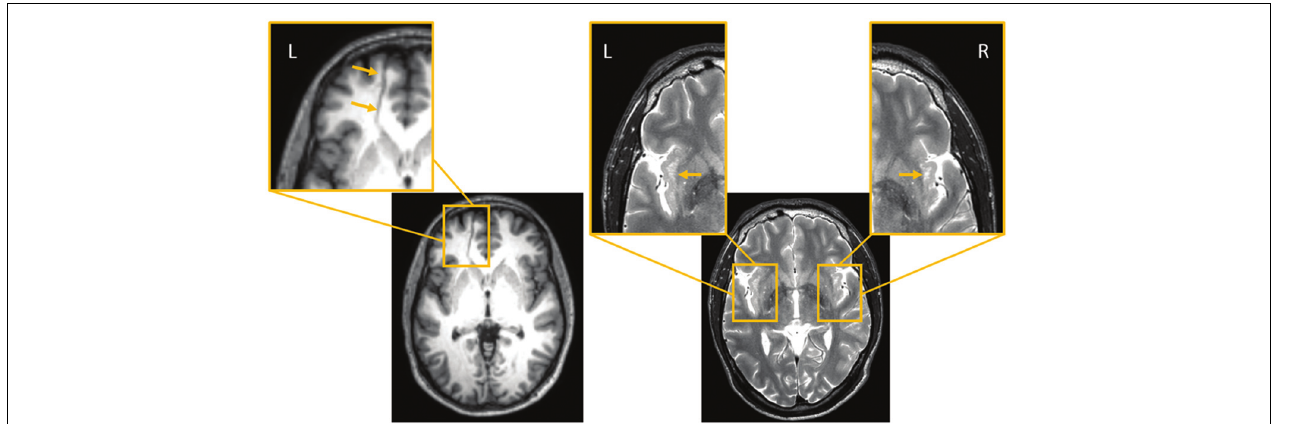
FIGURE 2 | (Left) : Subject 1. (1) Axial FLAIR MRI image shows a transmedullary vein close to the head of the left caudate nucleus crossing the medial frontal lobe substance and reaching the superior longitudinal sinus. This region has been expanded to depict the venous angioma (orange arrows; left panel, inset). (Right) : Subject 2. (2) Axial T 2 -weighted axial MRI imaging shows enlarged perivascular spaces in both insular cortices; the largest one are in the left anterior insula (orange arrows, insets). L indicates left and R right sides of the brain.